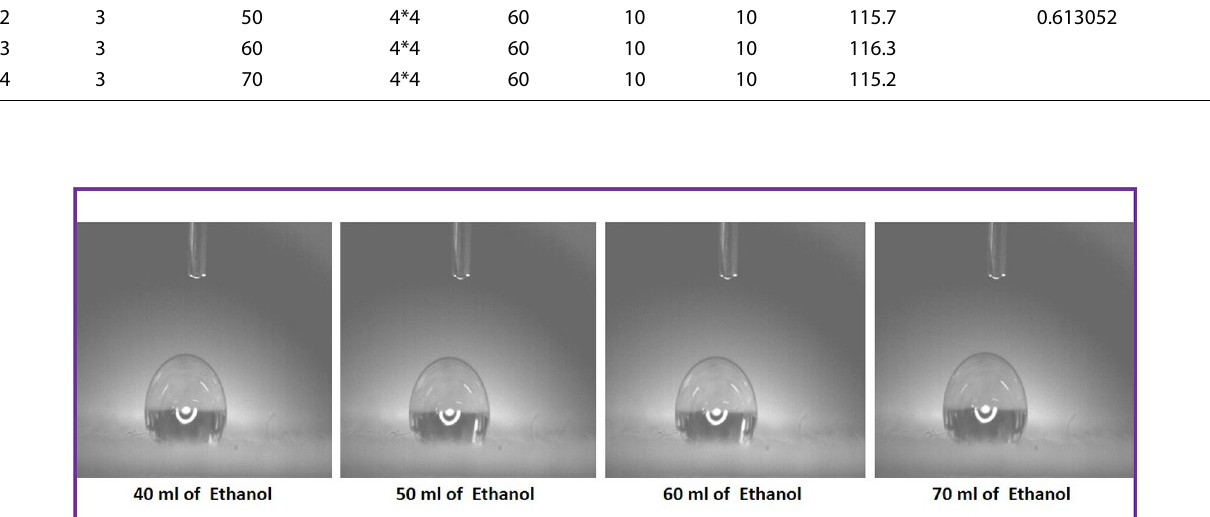
Fig. 11 A graphical demonstration of the influence of the stirring time on contact angle Table 6 Different contact angle for different amount of ethanol within same parameters Experi- ment no